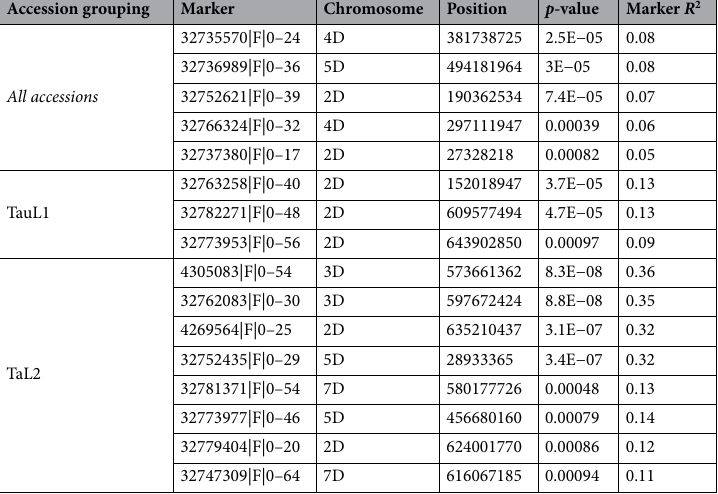
Accession grouping Marker Chromosome Position p -value Marker R